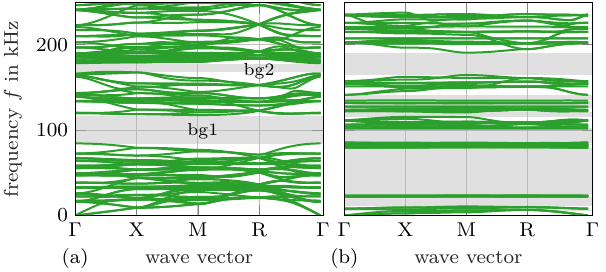
Figure 2. Simulated dispersion curves for ( a ) Sample 1 and ( b ) Sample 2. The resulting band gaps are highlighted in grey.